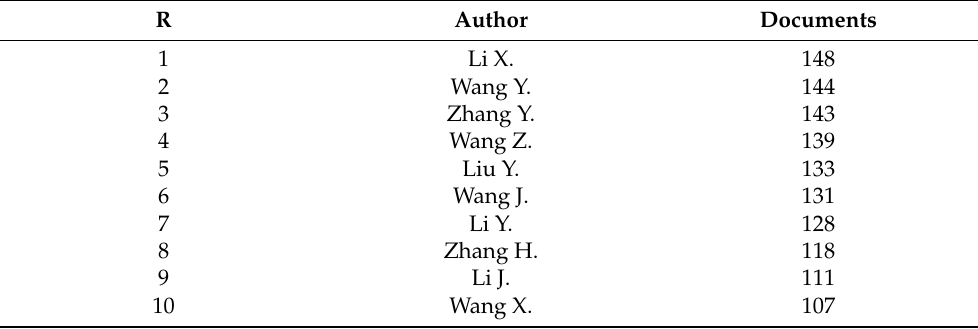
Table 4. Most productive countries in the leading AI journals during (2020 and 2021).